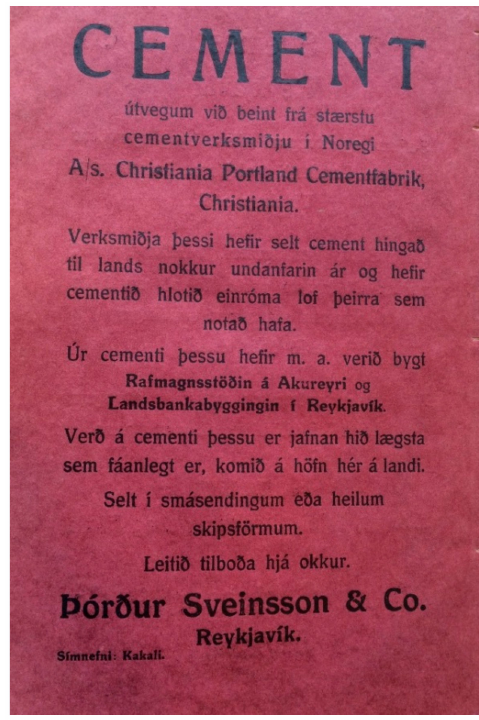
Figure 10. Advertisement for the cement produced at the factory of A/S Christiania, Norway. Copy available at the Reykjav í k City